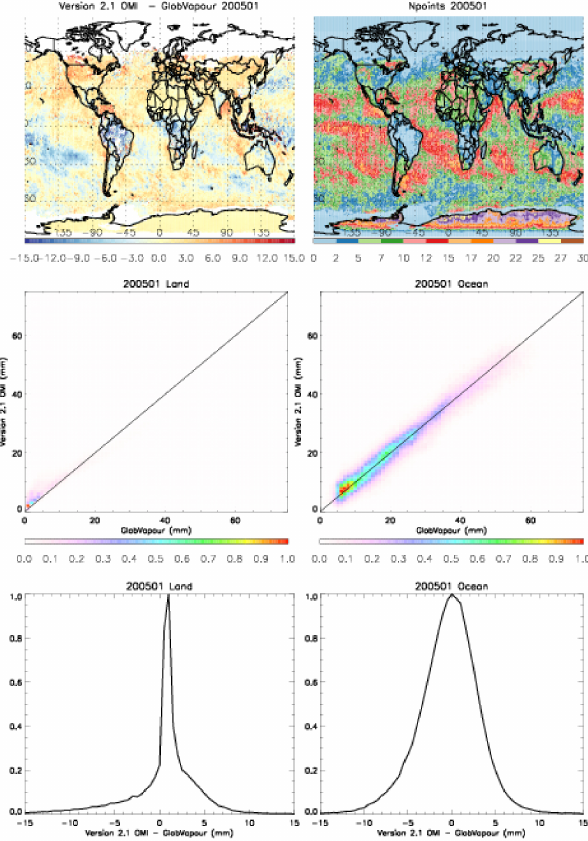
Figure 14. The same as Fig. 13 but for January